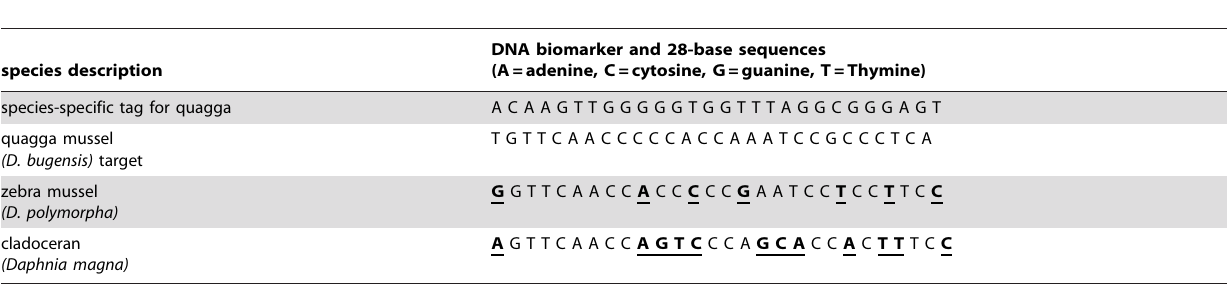
Table 1. Comparison between species-specific oligonucleotide tags and biomarkers where the differences are bold and underlined.